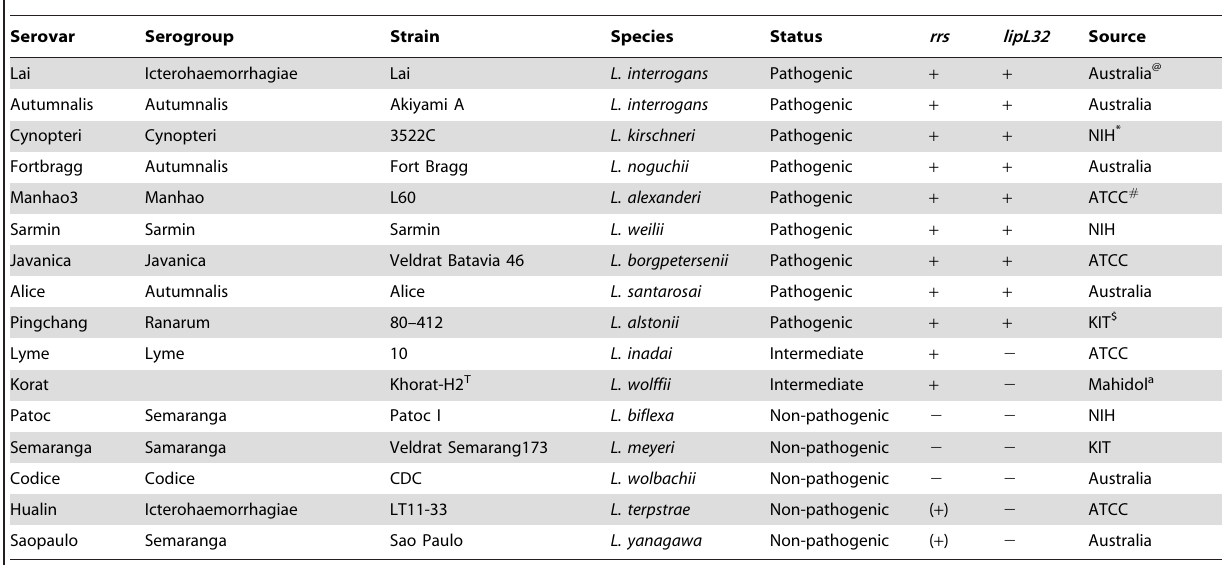
Table 1. Leptospira spp. used during this study.